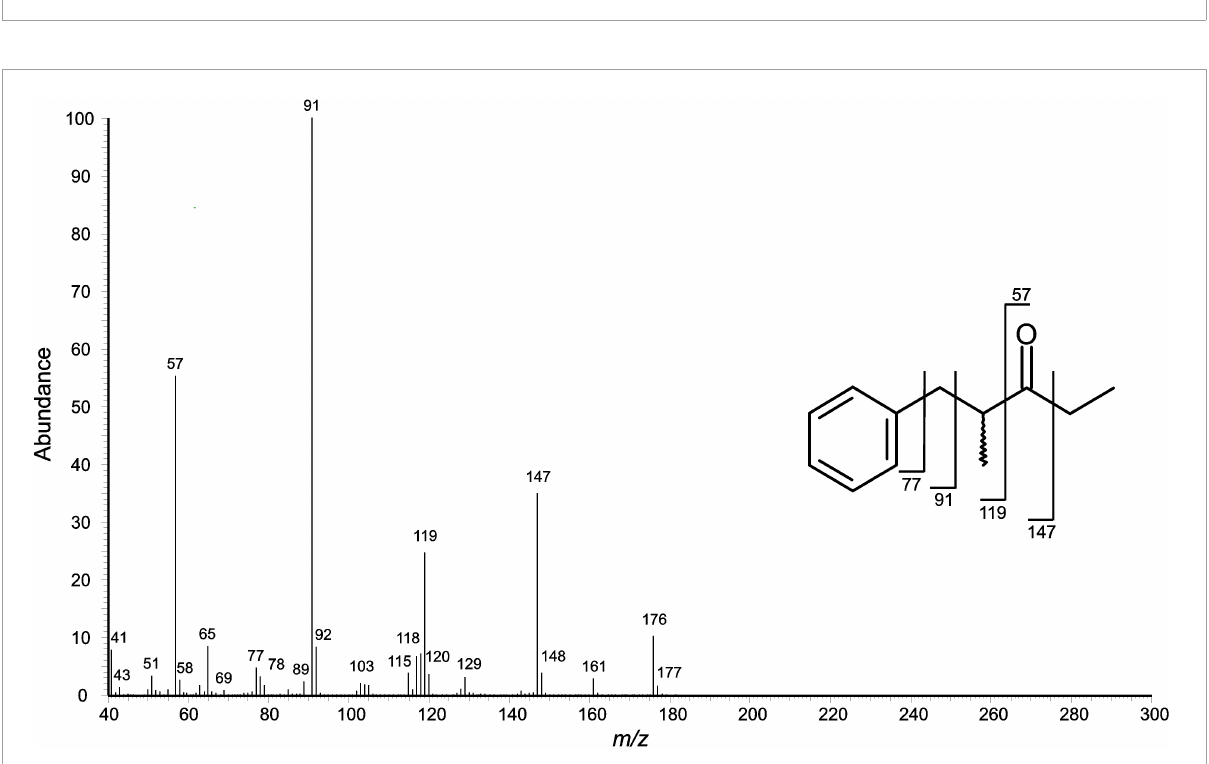
FIGURE4 Mass spectral (EI) fragmentation of aromatic compound E [(2 R )-2-methyl-1-phenyl-pentan-3-one]. Fragment ions from α -cleavage can be seen at m/z 57 and 147.